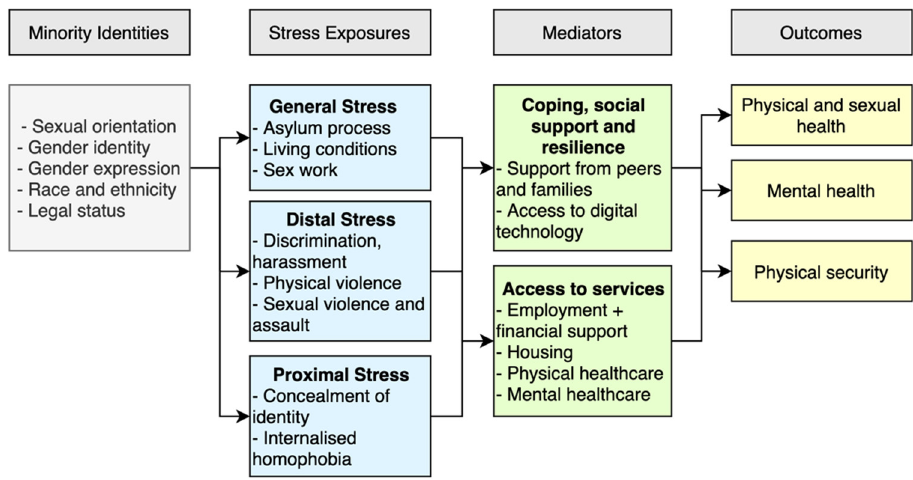
Figure 4. Framework describing potential pathways of minority stress amongst forced migrants with diverse SOGIE.